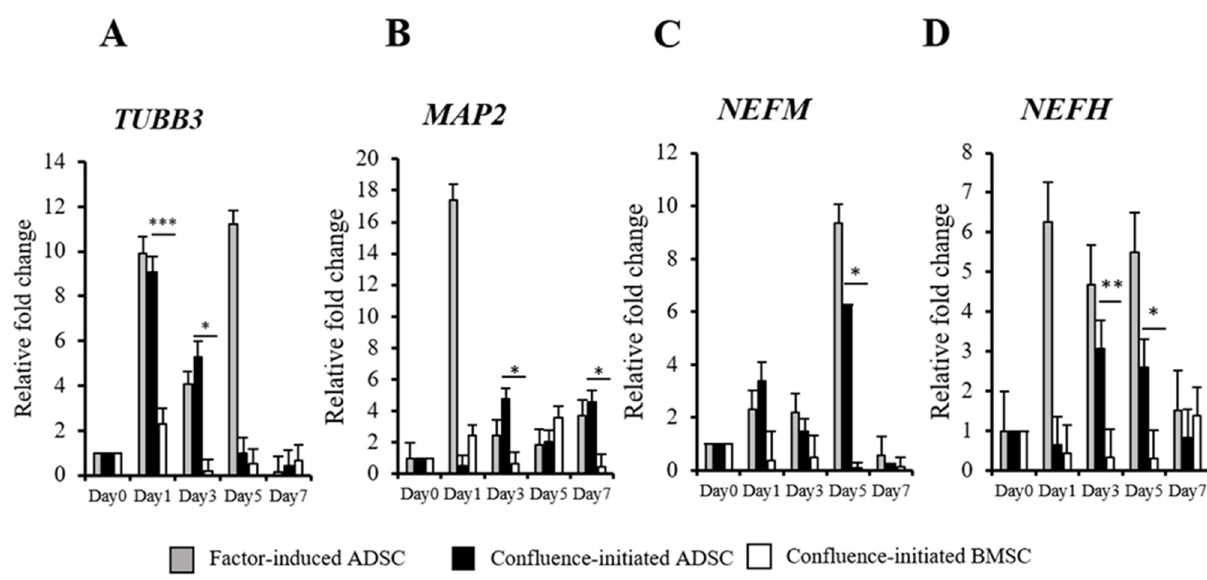
Figure 2. Comparison of neuron-related gene expressions of the ADSCs and BMSCs during confluence-initiated neurogenic differentiation. The time course experiments of detecting neuron-associated gene expressions include class III β -tubulin ( TUBB3 ) ( A ), microtubule-associated protein 2 ( MAP2 ) ( B ), neurofilament medium polypeptide ( NEFM ) ( C ), and neurofilament heavy polypeptide ( NEFH ) ( D ) in the spontaneously differentiated ADSCs after high confluence was achieved in the cultures by RT-qPCR. The value of each gene expression was normalized to the expression of glyceraldehyde-3-phosphate dehydrogenase ( GAPDH ). Relative fold changes of the values from day 1 to day 7 were compared with the value of day 0 (without induction) as one. The values are expressed as mean ± S.D. with three experimental replicates. Statistical significance to compare confluence-initiated differentiation of the ADSCs and BMSCs was determined using one-way ANOVA analysis. “*” represents p < 0.05. “**” represents p < 0.01. “***” represents p < 0.001.